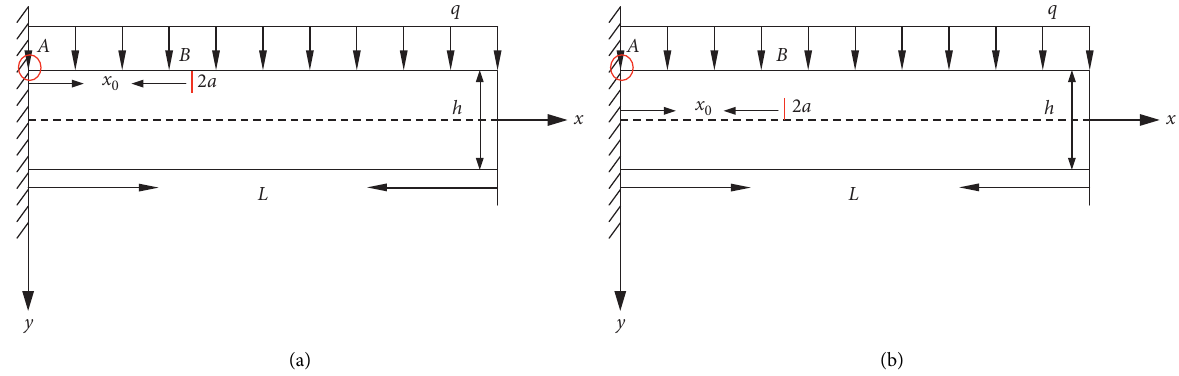
Figure 5: Stress analysis diagrams of roof with crack. (a) Roof with crack at edge. (b) Roof with crack at neutral layer.